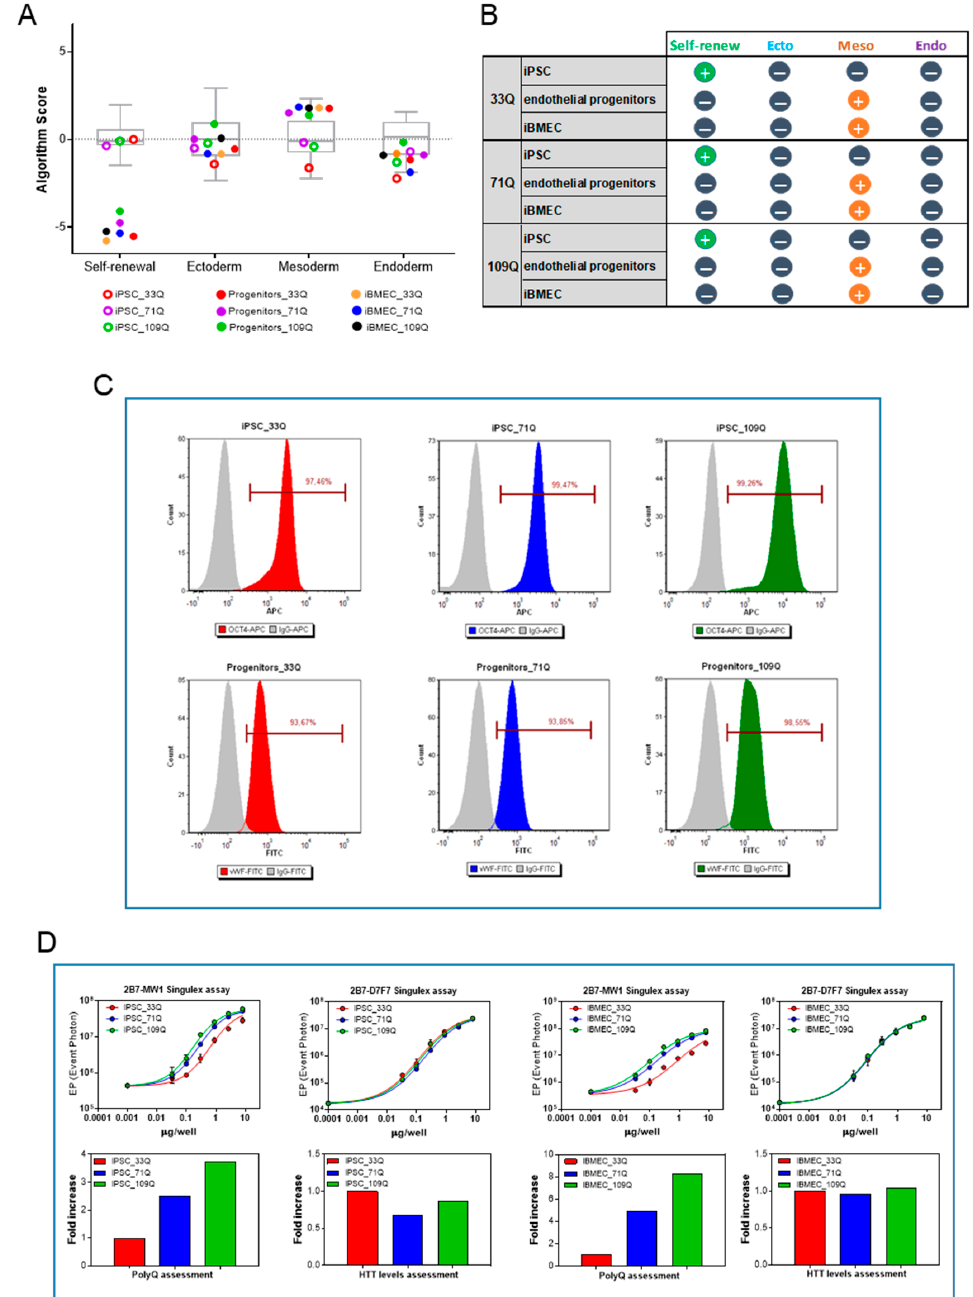
Figure 1. iPSC differentiation into iBMECs. ( A ) Scores box plot. View samples scores (colors) in relation to the range of scores for the undifferentiated reference set (gray) for cultured iPSC (empty circles), progenitors (D8), and iBMECs (D10) (filled circles). ( B ) Summary of gene expression level data in each category for the tree differentiation stages of the three cell lines. ( C ) Representative flow cytometry anal- ysis of OCT4 during routine culture of iPSC and of VWF before final differentiation. ( D ) Analysis of mHTT and HTT expression in 33Q, 71Q, and 109Q iPSCs (left panels) and iBMECs (right panels) using 2B7-MW1 and 2B7-D7F7 Singulex assay, respectively. Curve fittings of the serially diluted samples (de- scribed by a four-parameter logistic curve fit) are shown in the top panels, mean ± sd of 3 replicates. The bar charts (bottom panels) reported the fold increase among the different samples (fixing 33Q as reference = 1) and were derived from the EC 50 of the curve fittings above.